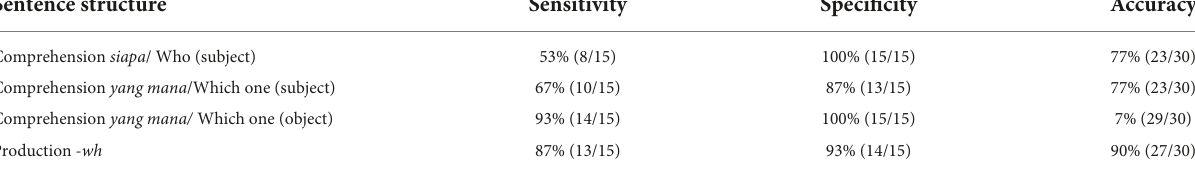
TABLE 9 Sensitivity, specificity, and accuracy values for Wh-